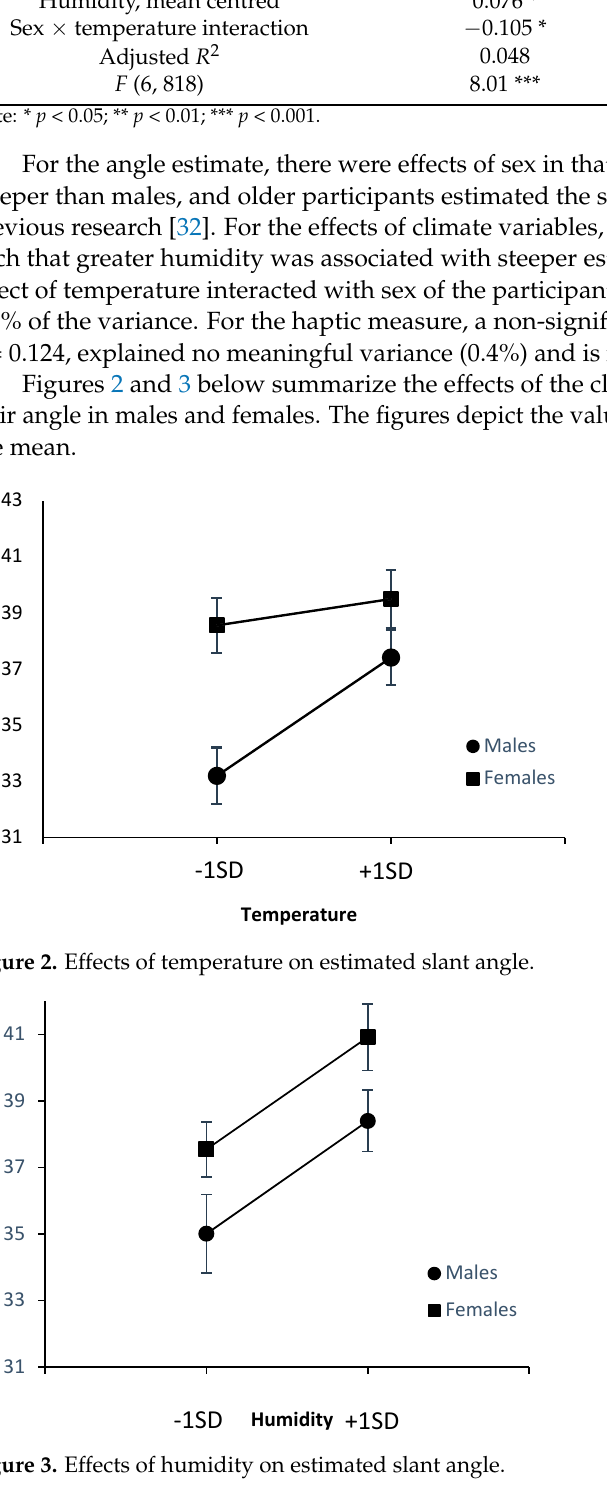
Figure 3. Effects of humidity on estimated slant angle.